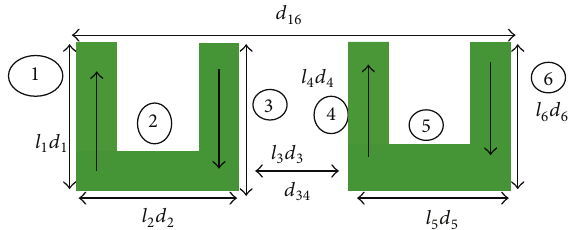
Figure 3: U-patch model for mutual coupling approach.